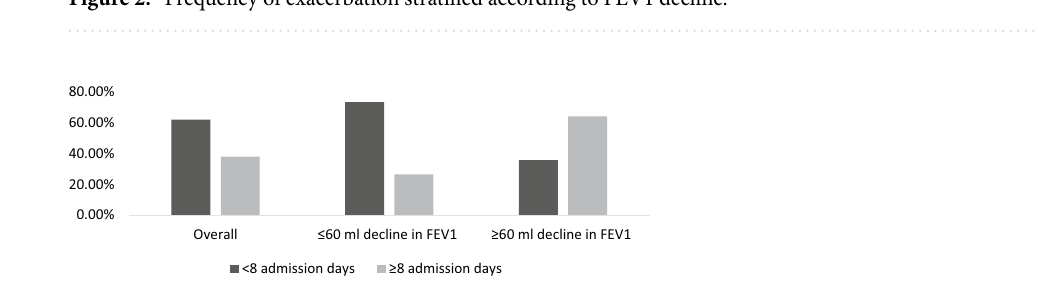
Figure 2. Frequency of exacerbation stratified according to FEV1 decline.